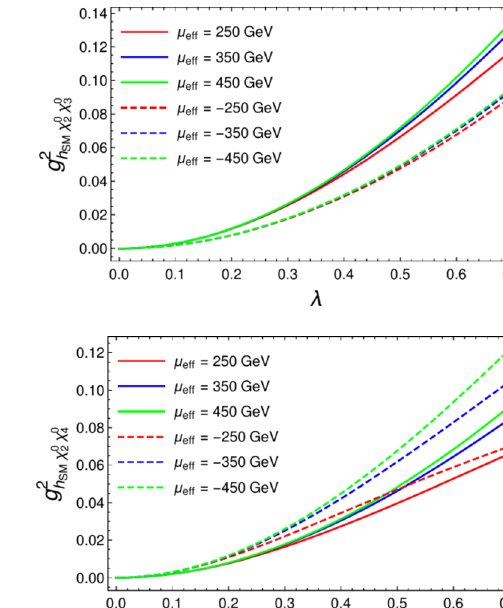
JHEP04(2021)122 (top, left), g 2 (top, right), g 2 (bottom, left) Zχ 0 2 χ 0 3 h SM χ 0 2 χ 0 3 Zχ 0 2 χ 0 4 using relations (C.5) eff are higgsino-dominated. For all the plots m = 3 , 4 e S